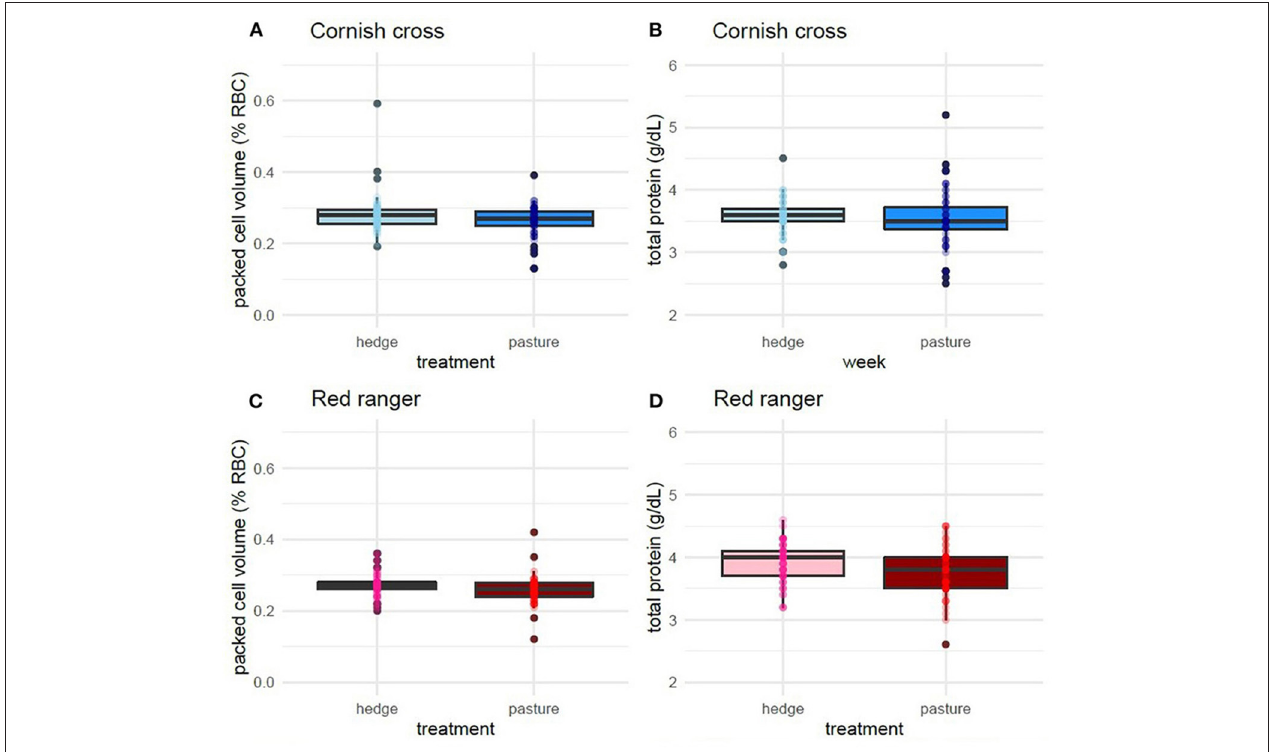
FIGURE 5 | Effect of treatment (hedge access) on packed cell volume (A,C) and total solids (B,D) for both breeds. Red rangers raised with a hedgerow show a lower degree of hemodilution compared to Red rangers raised in bare pasture (C,D) . Hedge access had no significant effect on hemodilution of Cornish cross (A,B) . LMEM PCV ∼ treatment + week + sex + (1|Block:Pop:ID). LMEM total solids ∼ treatment + week + sex +